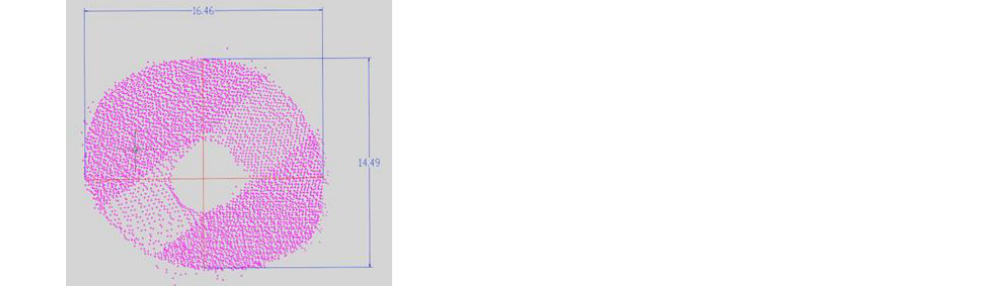
Figure 11. 3 D overlay of retrieved scour model for Trial 1 [35,36] (used with permission). For Trial 1, the absolute error in width is 0.12 inch, 0.16 inch in length and 0.09 inch in height.